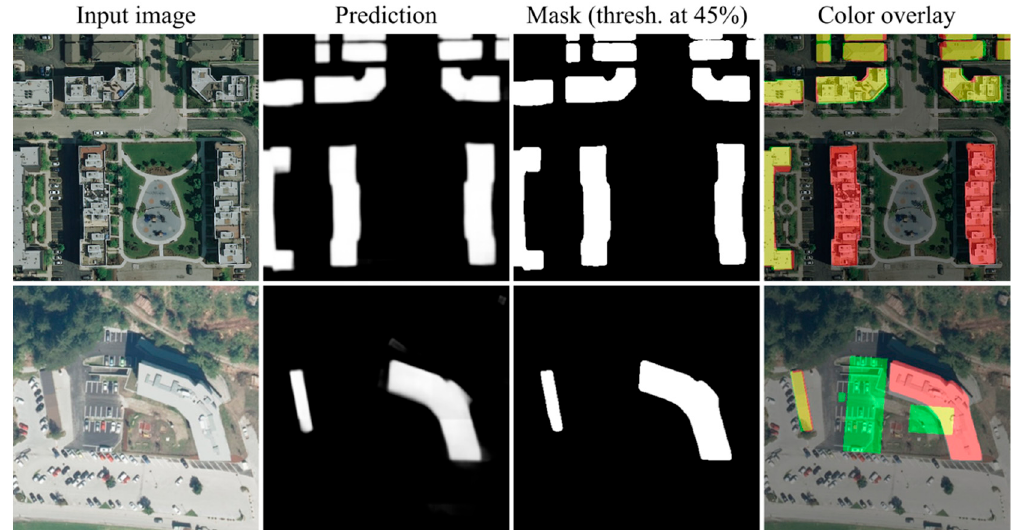
Figure 12. Examples of errors in the dataset that led to a mismatch between the output and the ground truth. The color overlay shows the obtained mask in red and the ground truth in green, resulting in a yellow overlay where those two overlaps.